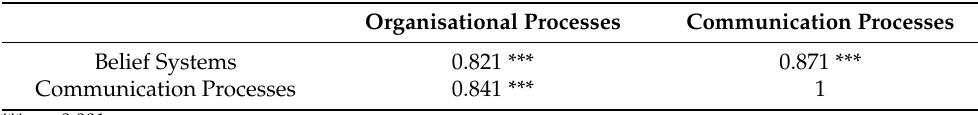
Table 4. Correlations between scales of